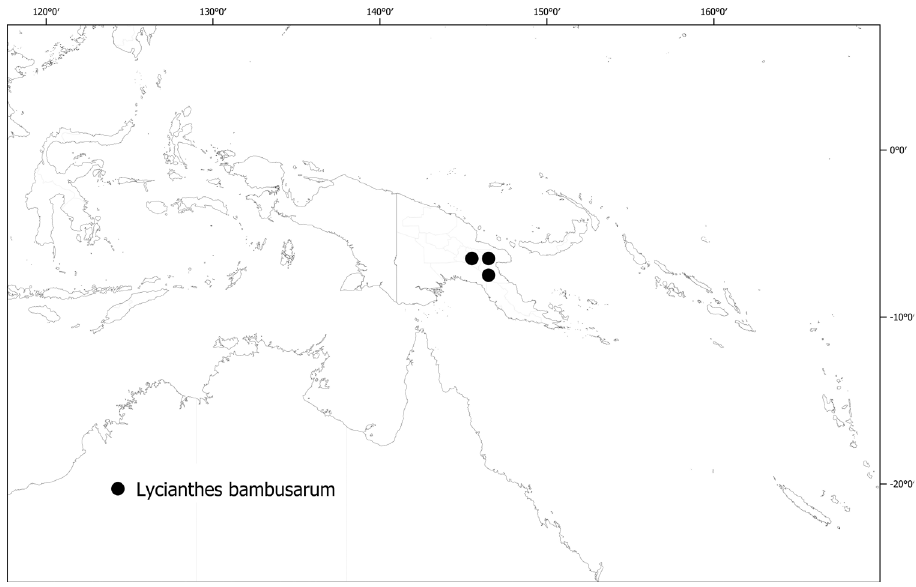
Figure 6. Distribution of Lycianthes